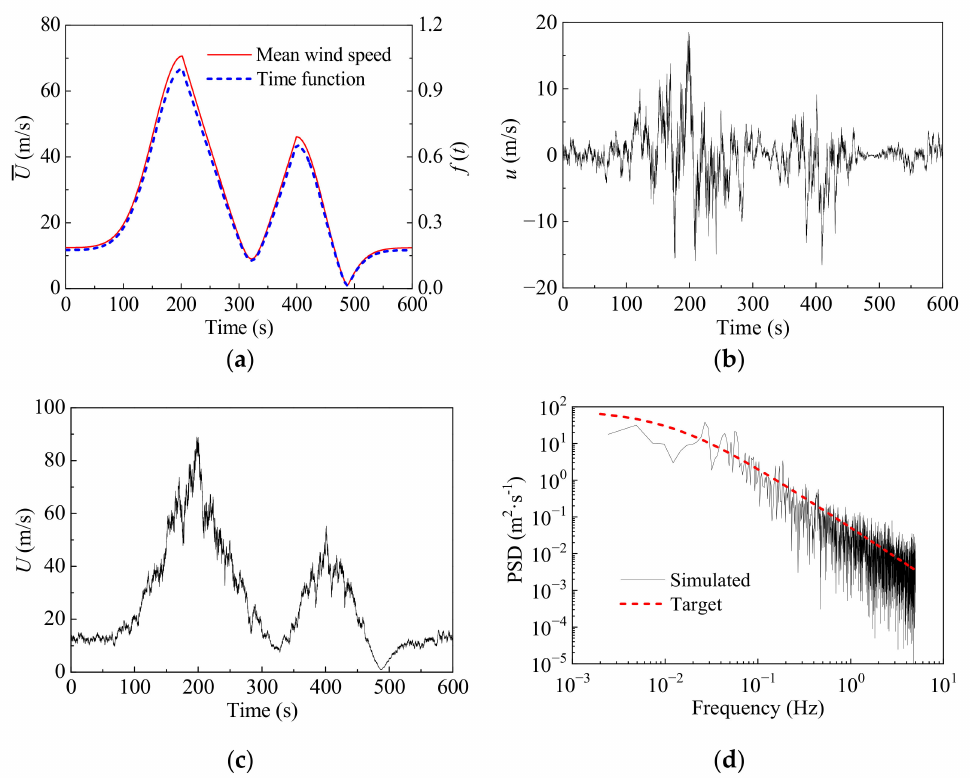
Figure 3. Simulated downburst at node 9: ( a ) mean wind speed and time function; ( b ) fluctuating wind speed; ( c ) total wind speed; ( d ) comparison of the PSDs.